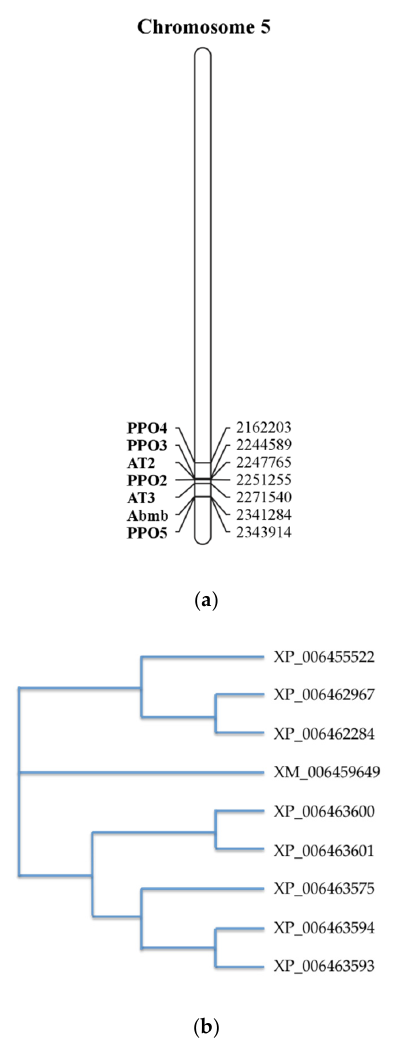
Figure 5. ( a ) The gene assembly in the region surrounding the Abmb encoding gene [4]. Numbers on the right refer to the position of the gene in the nucleotide genome sequence. AT stands for (4-hydroxy)phenylpyruvate amino transferase ( b ) Phylogenetic relationship between Abmb (GenBank ID XM_006459649) with other putative Ricin B-like lectins in A. bisporus . The phylogenetic tree was generated upon the amino acid sequence alignment using the program ClustalOmega [27]. PPO, polyphenol oxidase; Abmb, A. bisporus mannose-binding protein.